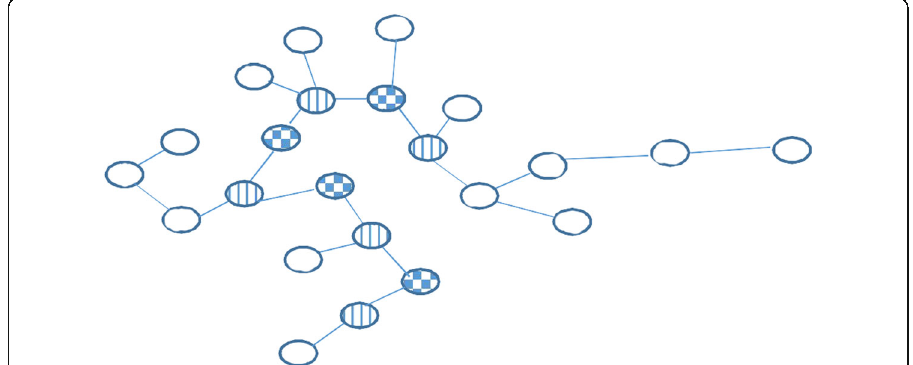
Fig. 4 A five partitioned WSAN after restoration